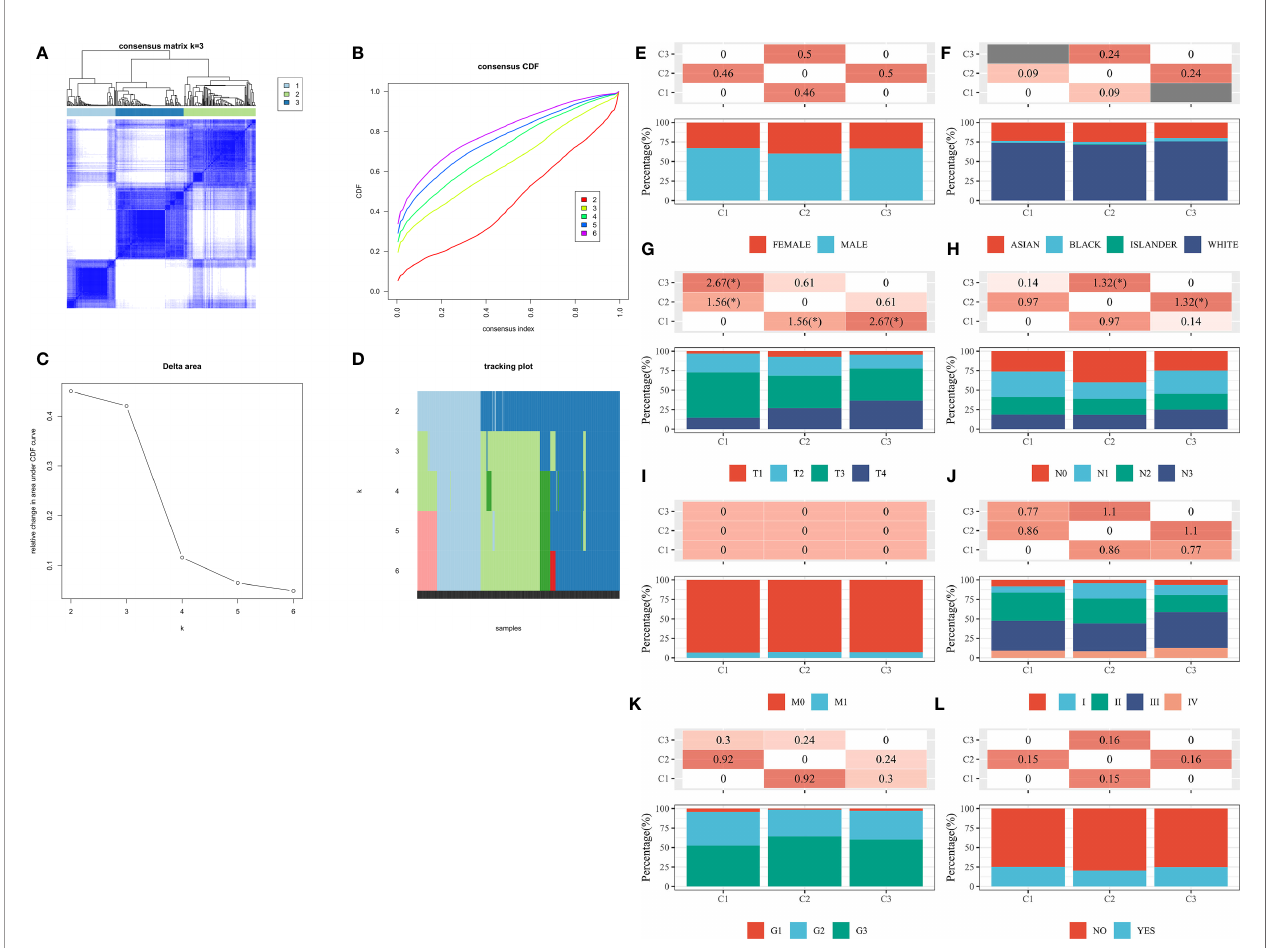
FIGURE 3 | Consensus clustering of m6A RNA methylation regulators to analyze the characteristics and survival of STAD patients. (A) The STAD cohort was separated into three clusters when k = 3. (B) CDF curves for k=2~6. (C) Relative amount of change in area under the CDF curve for consensus clustering when k=2~6. (D) The distribution of each sample when k is in the range of 2 ~ 6. (E) Comparison of gender differences among the 3 subgroups. (F) Comparison of race differences among the 3 subgroups. (G) Comparison of T-stage differences among the 3 subgroups. (H) Comparison of N-stage differences among the 3 subgroups. (I) Comparison of M-stage differences among the 3 subgroups. (J) Comparison of clinical staging differences among the 3 subgroups. (K) Comparison of differences in differentiation in 3 subgroups. (L) Comparison of differences in lymphatic metastasis among the 3 subgroups. Note: CDF, cumulative distribution function. *P < 0.05, **P < 0.01, ***P <